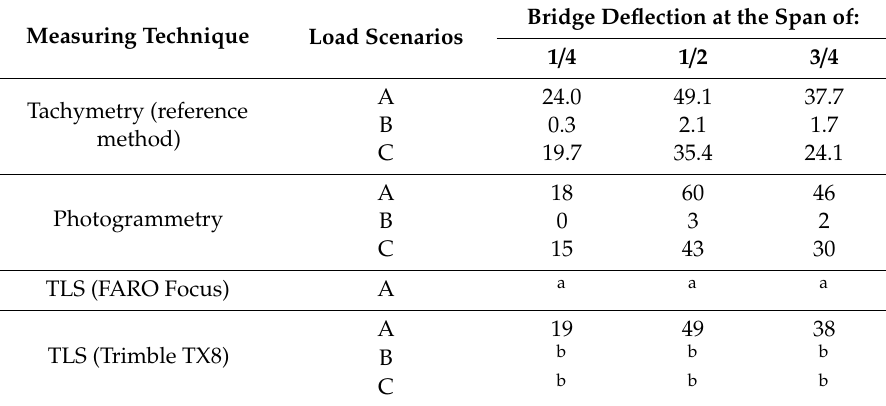
Figure 9. Bridge deflections under static loading (A) in chosen points received from the TLS technique (Trimble scanner). Table 2. Results of the maximum recorded bridge deflections (in